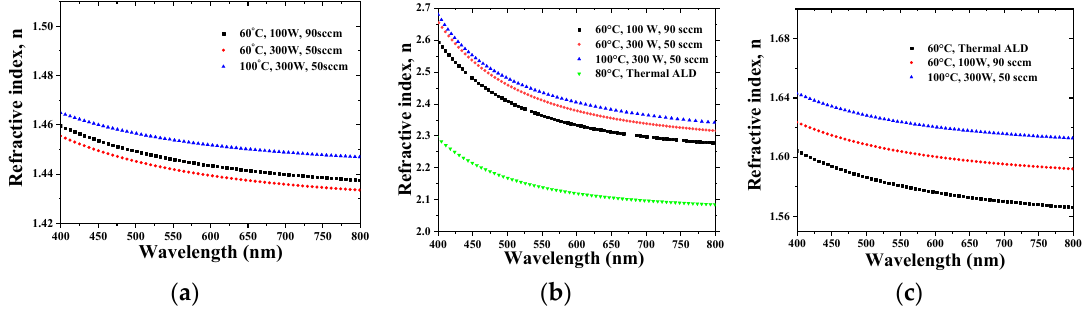
Figure 2. Refractive index ( n ) vs. wavelength for ( a ) SiO 2 , ( b ) TiO 2 and ( c ) Al 2 O 3 films at different temperature and plasma conditions.